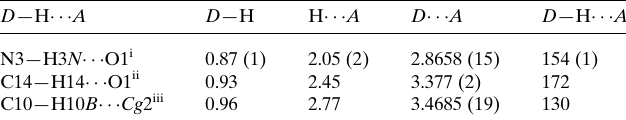
Table 1 Hydrogen-bond geometry (A˚ , (cid:2) ).